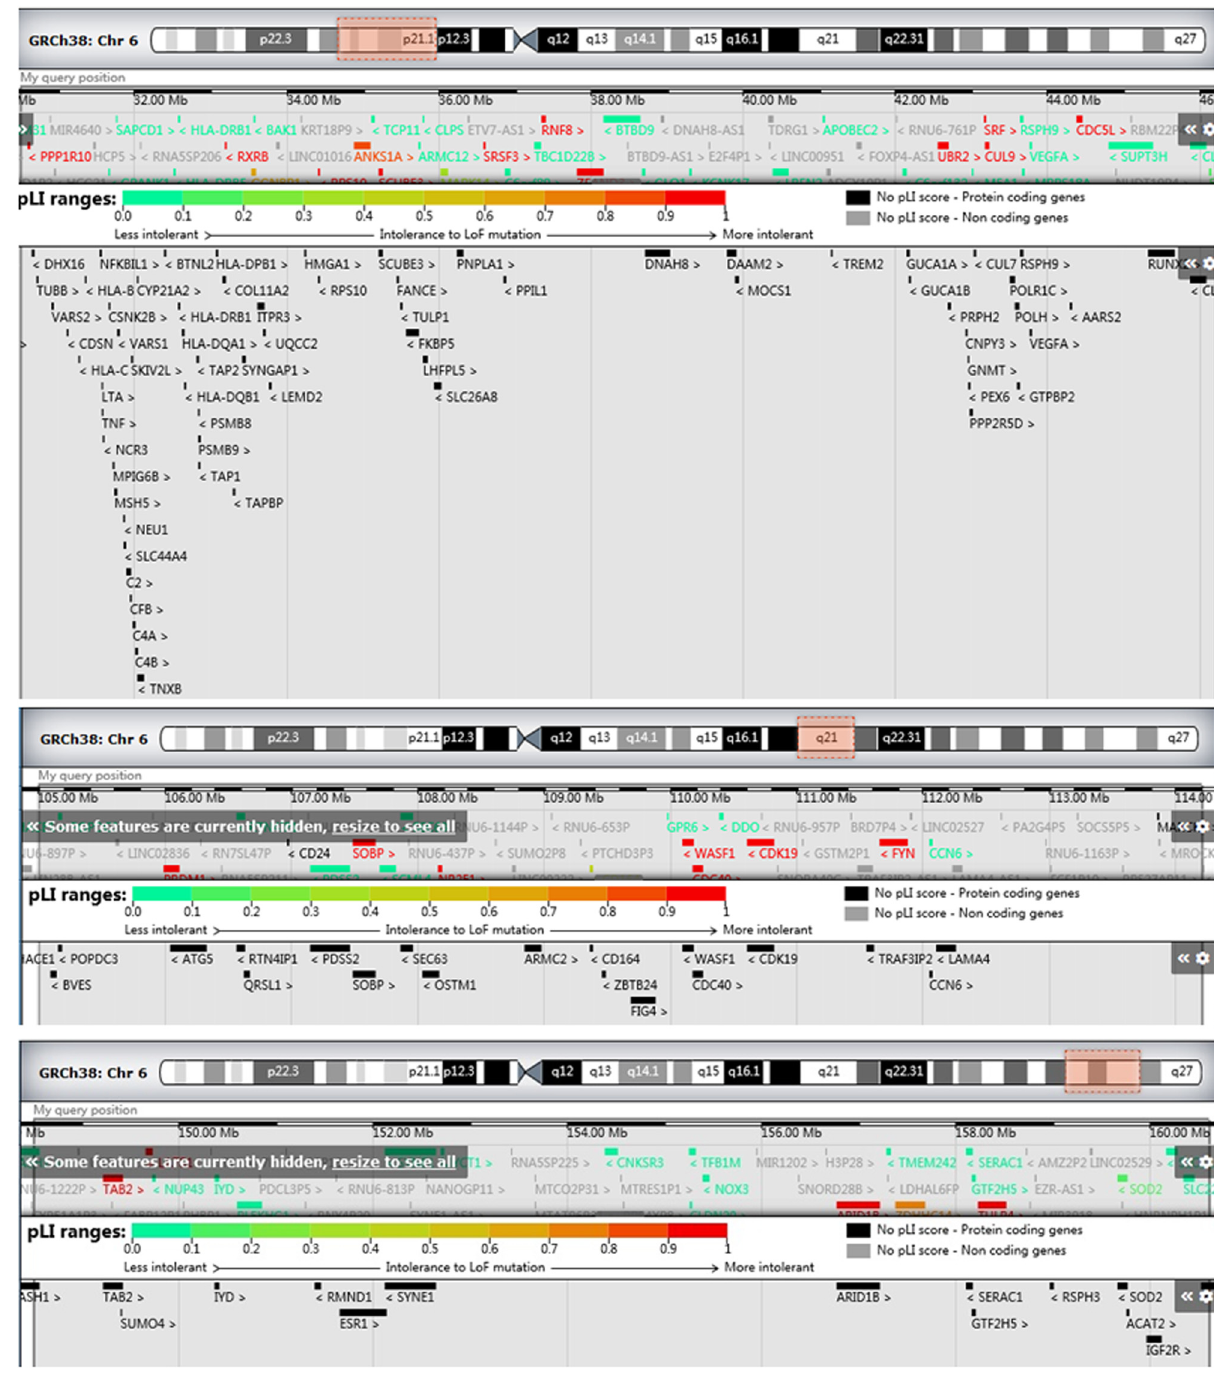
Figure 2: Genes associated with chromosomes 6p21, 6q21, and 6q25 in